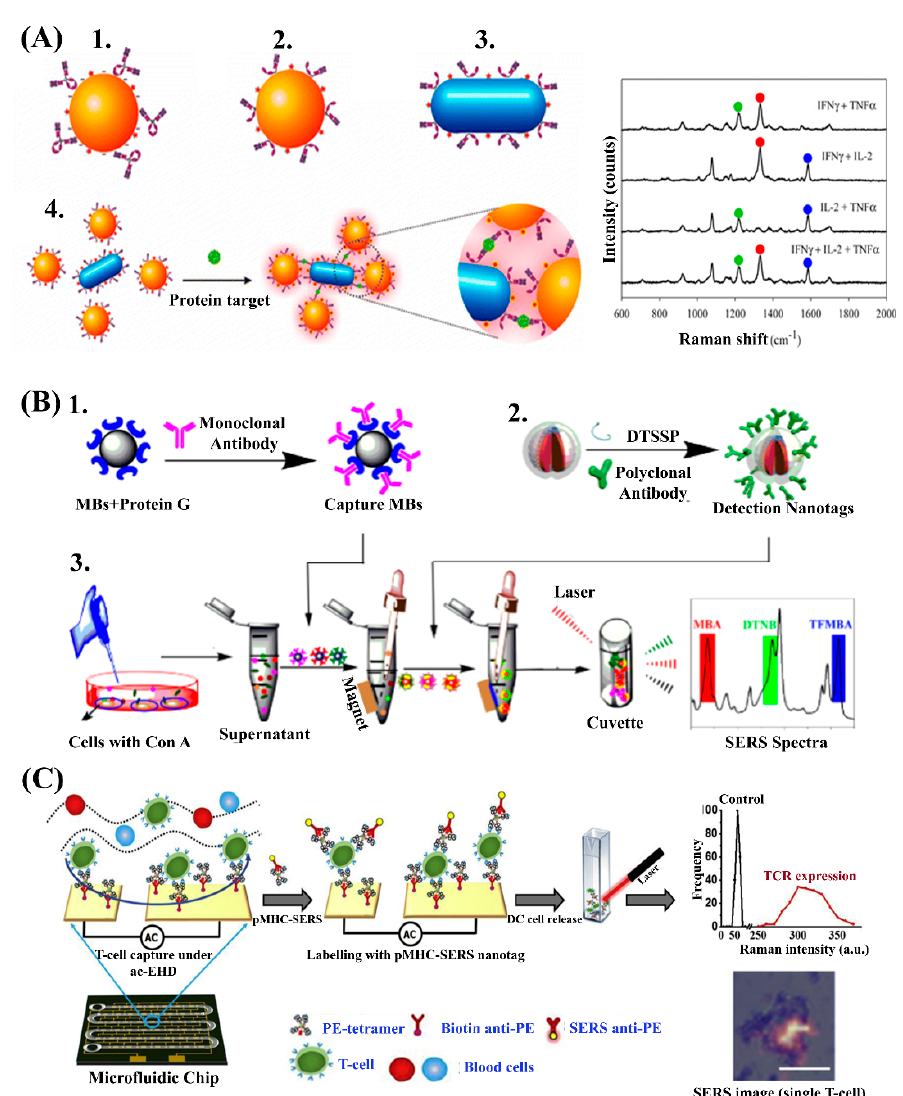
Figure 2. ( A ) Target-controlled assembly-based surface-enhanced Raman spectroscopy (TCA-SERS) immunoassay for multiplexed analysis of protein biomarkers. Reproduced from [50], with permission from the American Chemical Society, 2013. ( B ) SERS immunoassay for multiplexed detection of cytokines secretion. (1) Magnetic bead functionalization with capture antibody, (2) detection antibody immobilization on SERS nanotags comprising of tunable Raman reporters residing between gold cores and silver shells, and (3) schematic representation of the immunoassay. Reproduced from [52], with permission from the American Chemical Society, 2019. ( C ) An integrated SERS-microfluidic platform for antigen specific T-cell isolation and SERS mapping of T cell receptor expressions. Reproduced with permission from [53], with permission from Elsevier, 2019.